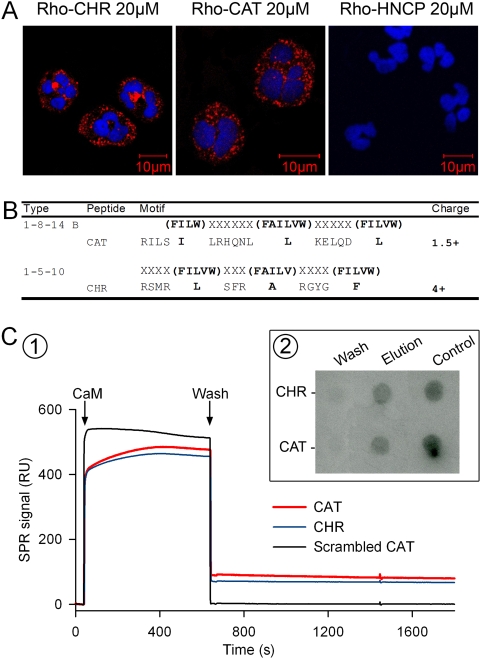
Interaction of CHR and CAT with calmodulin (CaM).A) Fluorescence confocal microscopy of PMNs after incubation during 120 s with 20 µM rhodamine-labeled peptides (Rho-CHR or Rho-CAT). Control peptide: 20 µM rhodamine labeled Hippocampal Cholinergic Neurostimulating Peptide (Rho-HCNP). The PMNs nuclei were labeled with Draq-5. B) Alignment of the CHR and CAT sequences with two CaM binding motifs 1-8-14 B and 1-5-10. The alignment has been obtained manually so that hydrophobic residues occupy invariant positions shown with boldface letters. The net positive charge is also indicated. C) (1) Interactions between CaM, CAT and CHR by Surface Plasmon Resonance (SPR) Peptides were immobilized on a CM5 Biacore chip using amine-coupling chemistry. CaM (5 µM) was added at arrow and allowed to stabilize for 10 min. Dissociation by washing was recorded for the following 10 min. All measurements were performed at 20°C. The resulting sensorgrams were analyzed using BIAevaluation Software. (2) Calmodulin-Affinity Chromatography of CHR and CAT. The retained and eluted peptides were immunodetected by dot blot with anti-CHR (monoclonal anti-CgA47–68) and anti-CAT (polyclonal anti-CgA344–364). Wash (5th wash after adsorption of peptides).